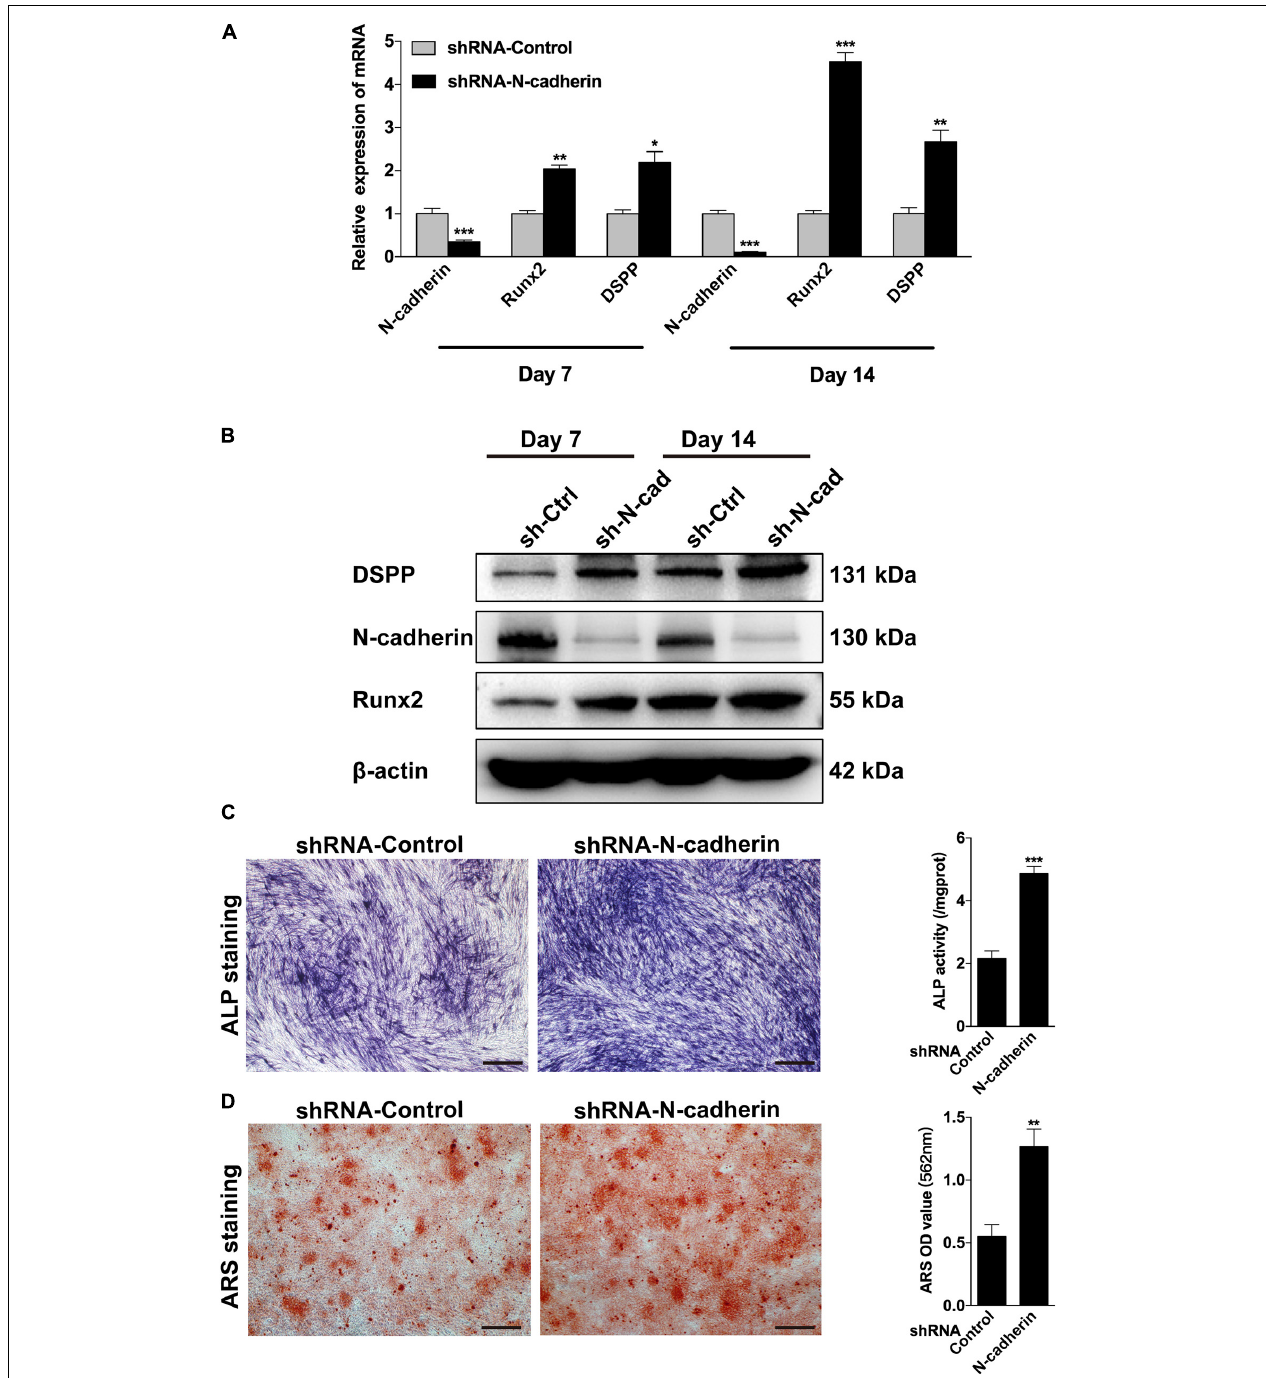
FIGURE 3 | N-cadherin knockdown promoted the odontogenic differentiation of dental pulp stem cells (DPSCs). DPSCs transfected with a control or N-cadherin-specific shRNA lentivirus were subjected to odontogenic induction for 7 or 14 days. The expression level of odontogenic-related genes (DSPP and Runx2) were detected by qPCR and western blotting on day 7 and 14 (A,B) . The alkaline phosphatase (ALP) activity was measured by ALP staining on day 7 (C) . The formation of mineralized nodules was detected by alizarin red staining (ARS) on day 14 (D) . Scale bars = 500 µ m. Data are presented as the mean ± SEM of three independent experiments. * P < 0.05, ** P < 0.01, *** P < 0.001.